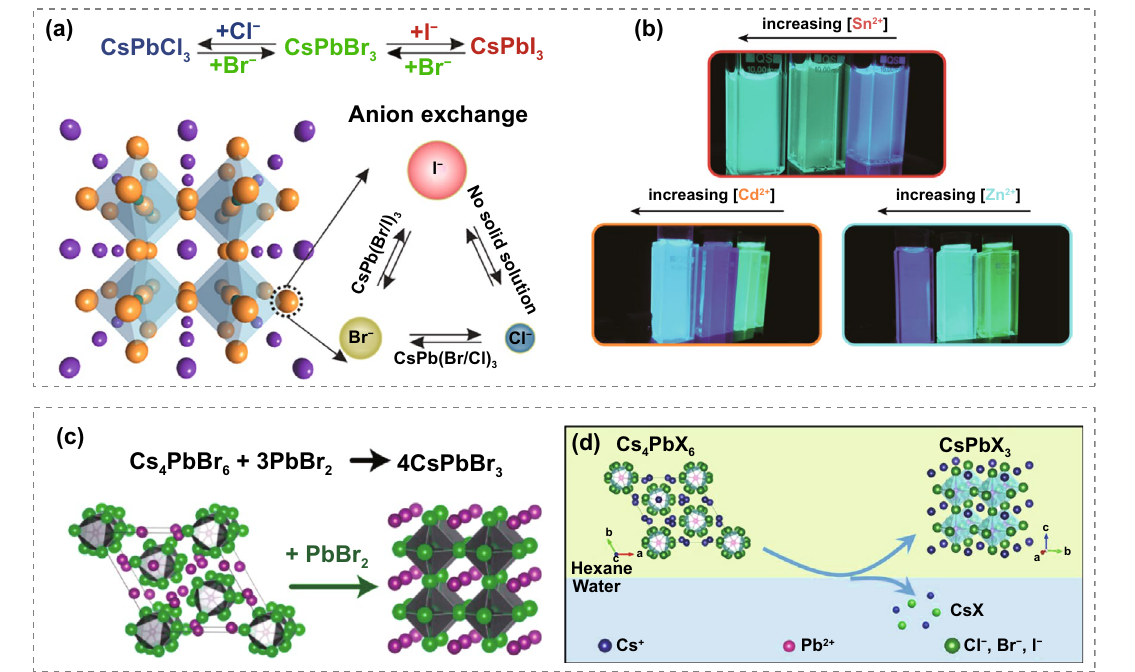
Fig. 3 a Schematic diagram of halide exchange in inorganic perovskite QDs. Adapted with permission from Ref. [122]. Copyright 2015, Ameri- can Chemistry Society. b Photos of CsPbBr 3 QD colloidal dispersion after reacting with divalent cation bromide salts under the UV excitation. Adapted with permission from Ref. [116]. Copyright 2017, American Chemistry Society. c Schematic diagram of transformation from Cs 4 PbX 6 to CsPbX 3 QDs. Adapted with permission from Ref. [123]. Copyright 2017, American Chemistry Society. d Schematic diagram of chemical conversion from Cs 4 PbX 6 to CsPbX 3 QDs. Adapted with permission from Ref. [124]. Copyright 2017, American Chemistry